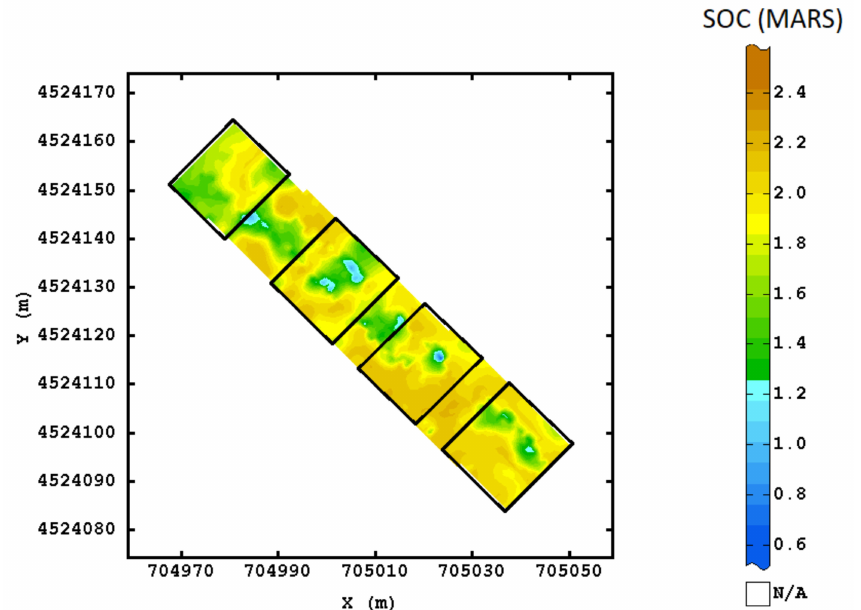
Figure 10. Map of SOC obtained with MARS model. The black polygons indicate the four blocks in the RCB experimental